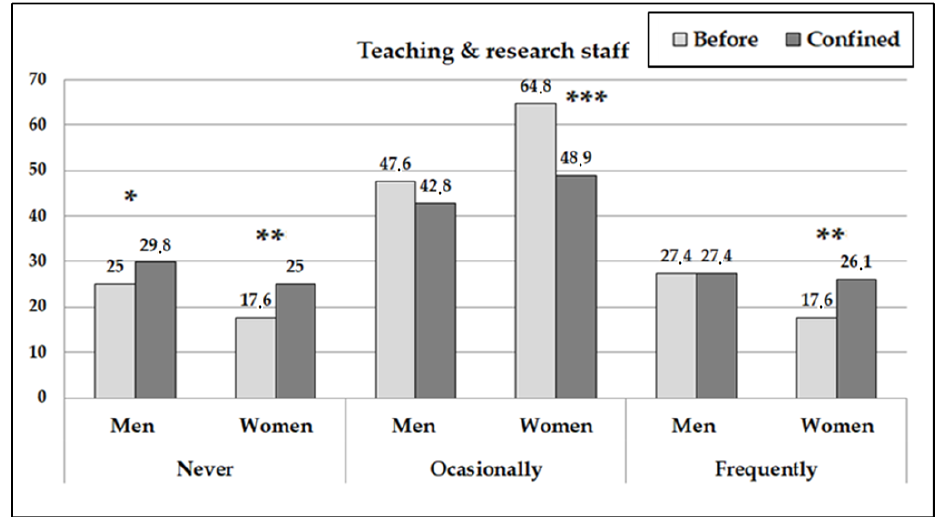
Figure 2. Percentages of teaching and research workers who carried out physical activity according to frequency before and after the confinement. (The asterisks indicate the significant differences before and during confinement by sex subgroup: * p < 0.05; ** p < 0.01; *** p < 0.001).